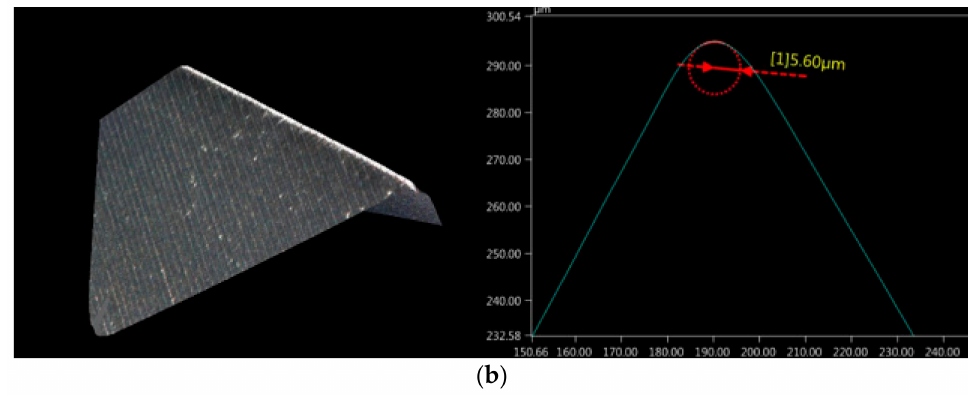
Figure 2. Cutting edge and its radius r n in a tool coated with ( a ) TiB 2 and ( b ) TiAlN.